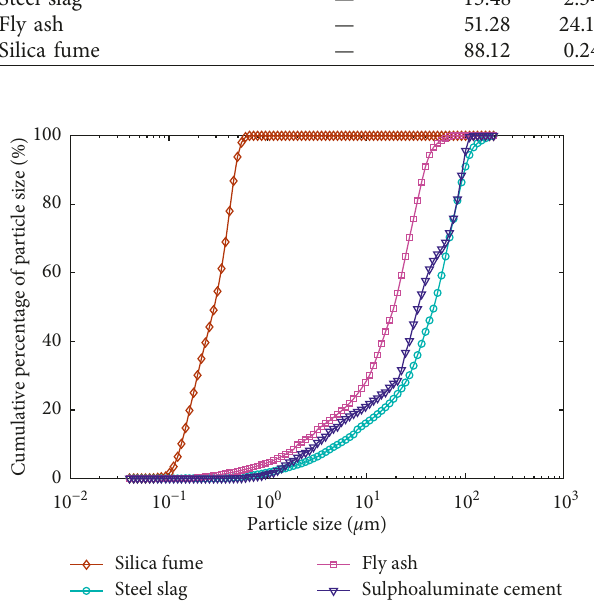
Figure 1: Cumulative percentage of particle size distribution of raw